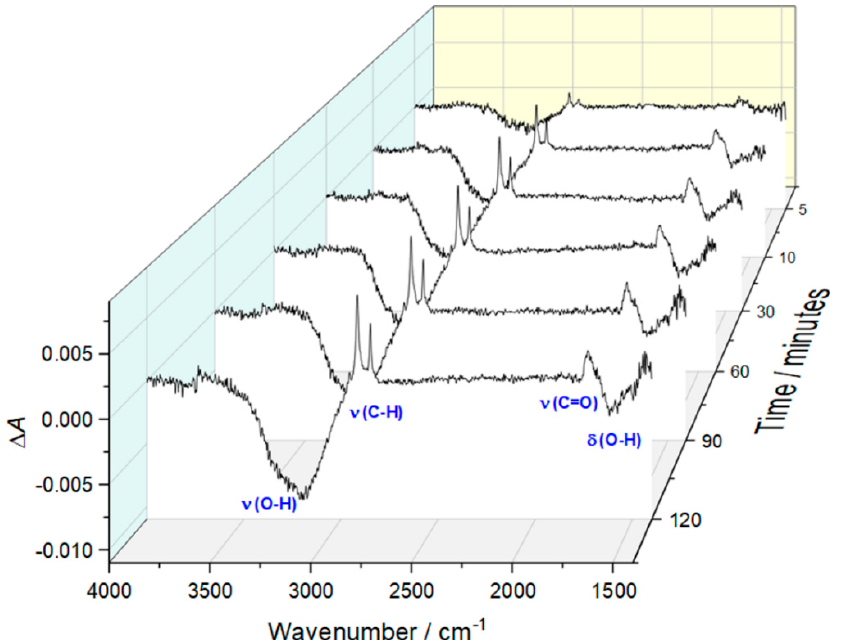
Figure 1. Time-evolution of surface-enhanced infrared absorption (SEIRA) spectra collected for thioglucose-modified gold during the deposition of bicelles. The reference spectrum was collected for gold film modified with monolayer of thioglucose.